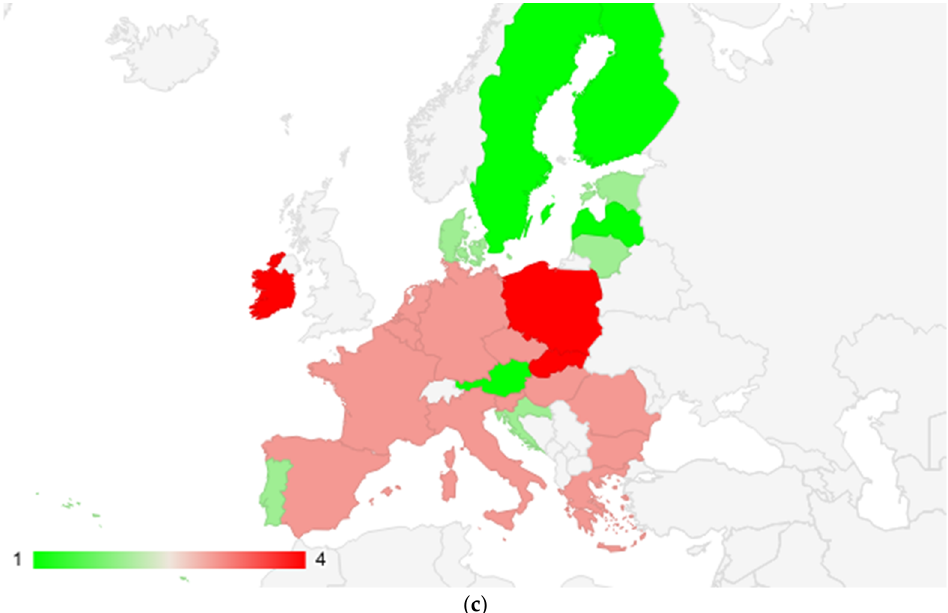
Figure 6. The division of the EU countries into similar classes in terms of the level of RES development in 2008 ( a ), 2013 ( b ), and 2018 ( c ) (own elaboration).